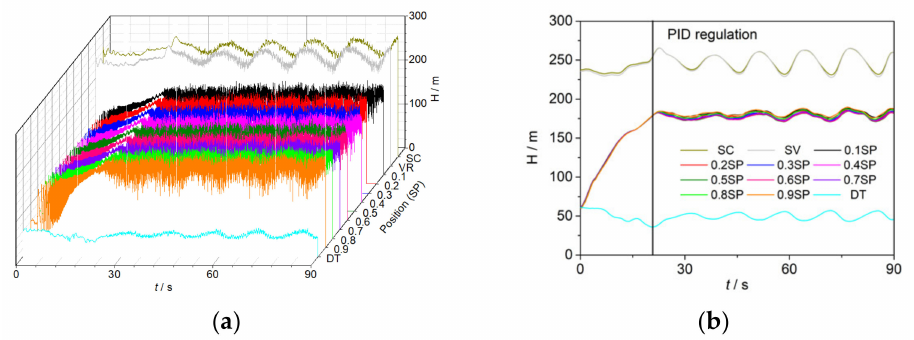
Figure 20. Dynamic pressure pulsations during start-up in Case2. ( a ) Original data; ( b ) The low-pass filtered